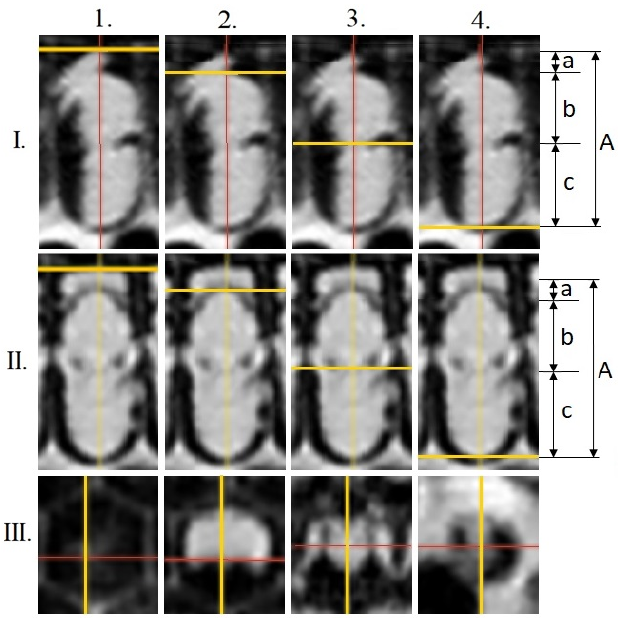
Figure 1. Different image reconstruction planes of examined brood cells as well as different measurement points at the 18th day of development of the pre-imaginal stage of the honey bee. I.: sagittal, II.: coronal, III.: transversal; 1, 2, 3, 4: the distances of measurements; a: head length, b: thorax length, c: abdomen length, A: total-body length.